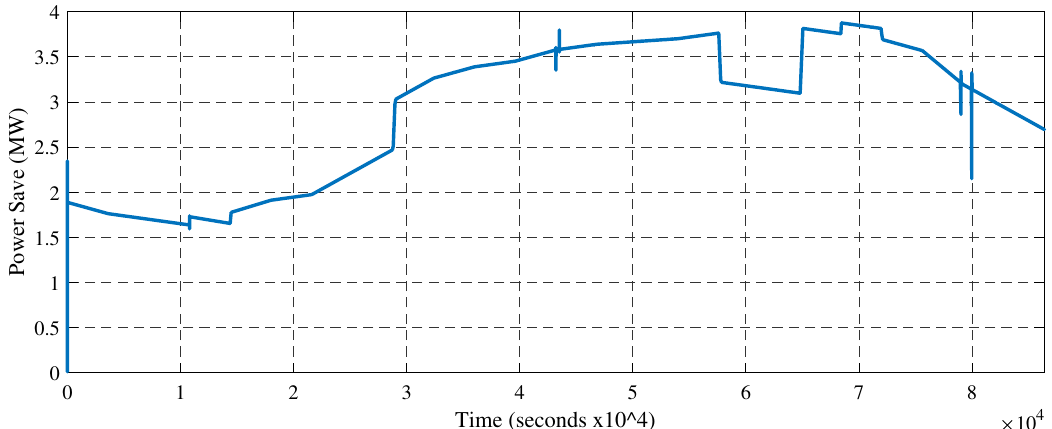
Figure 10. Power saving by the proposed EMS